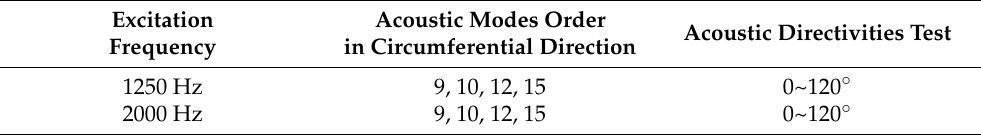
Table 2. The designed test conditions and experimental excitation.